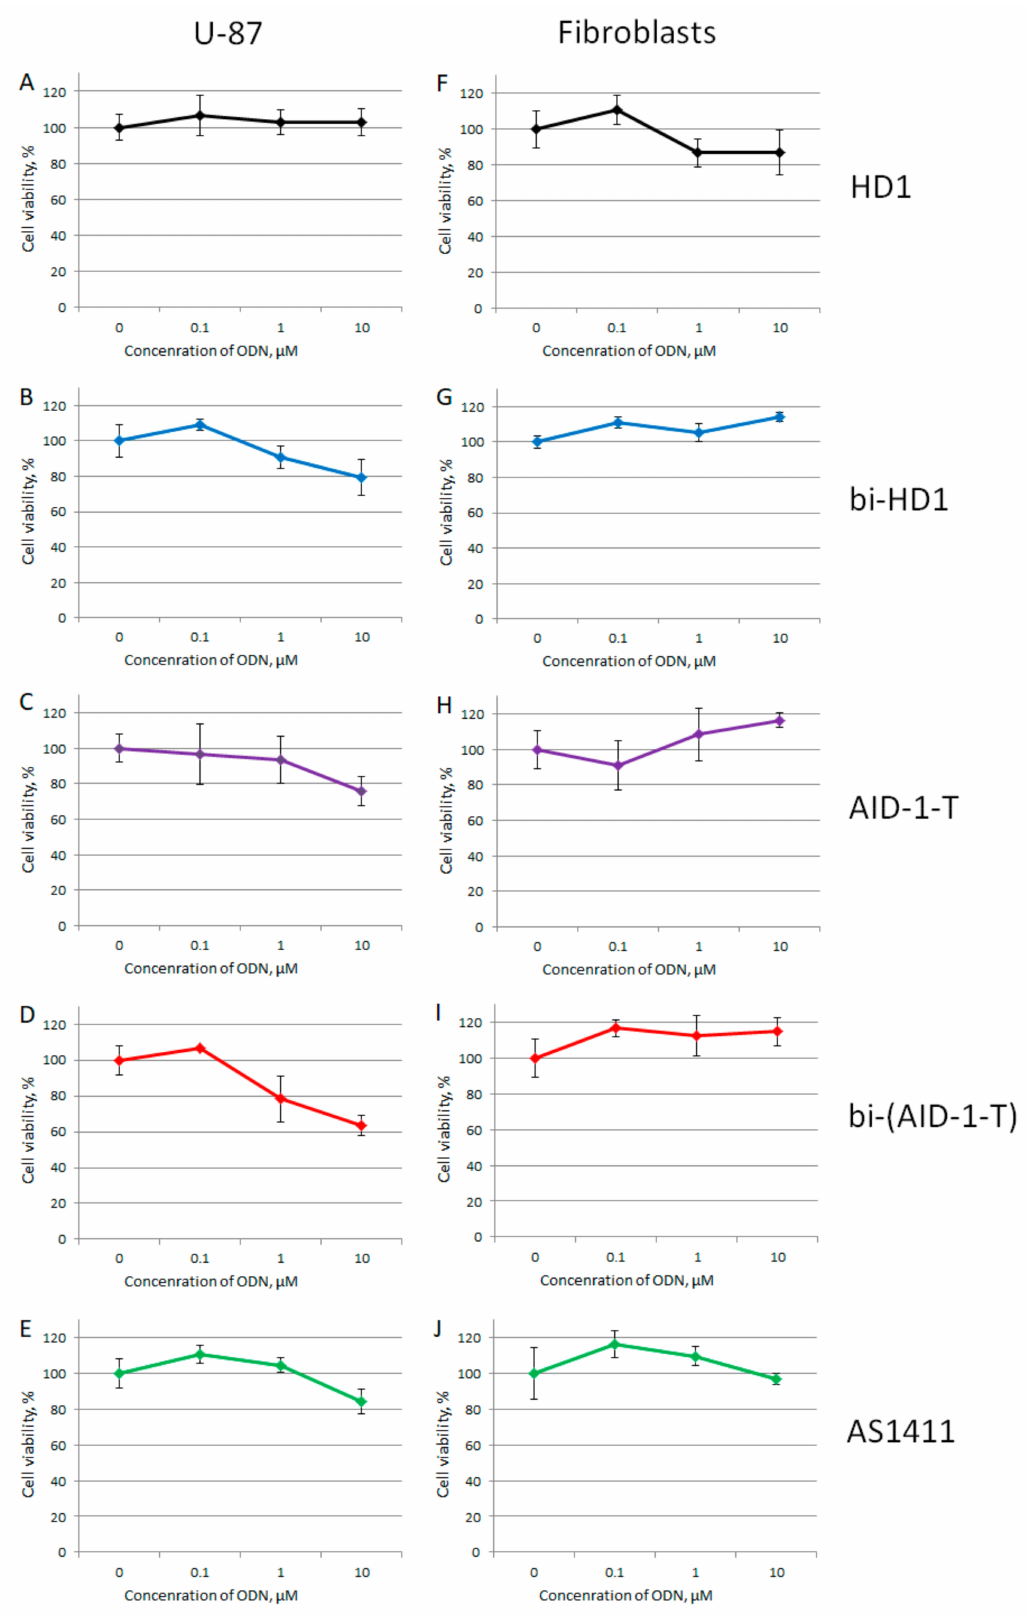
Figure 7. MTT assay data on the cell viability of two cell lines after GQ treatment with three different concentrations (0.1; 1.0, and 10 µ M) for 72 h. Human cancer cell line U87 ( A – E ) and embryonic fibroblasts ( F – J ). HD1 (black), bi-HD1 (blue), AID-1-T (violet), bi-(AID-1-T) (red), AS1411 (green). Data are shown as (mean +/ − S.D., standard